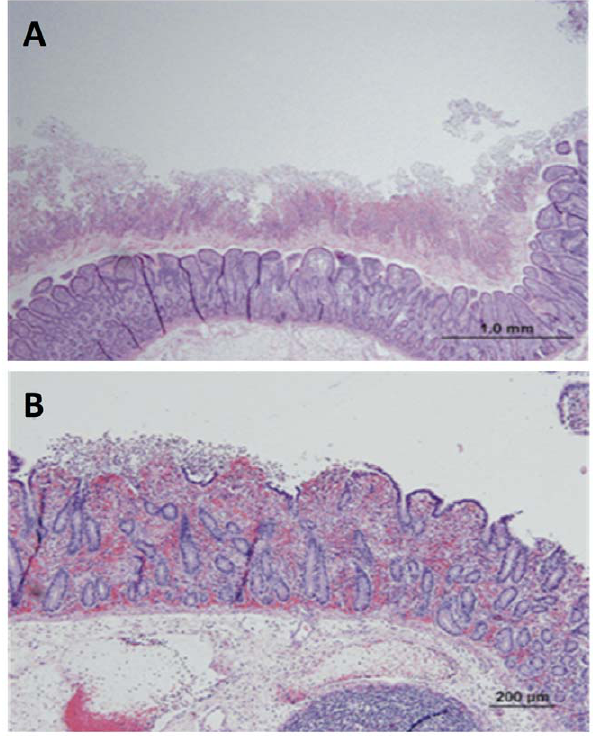
Figure 1. Microscopic sections of the ileal loops representing pseudomembrane formation due to the infection of C.difficile under the experimental conditions. (A) The mucosal surface is covered by a thick layer of fibrinopurulent exudate (‘pseudomem- brane’). Note the extensive submucosal edema. (B) Focal erosion of the surface enterocytes is accompanied by exudation of fibrin and neutrophils into the lumen of the intestine.